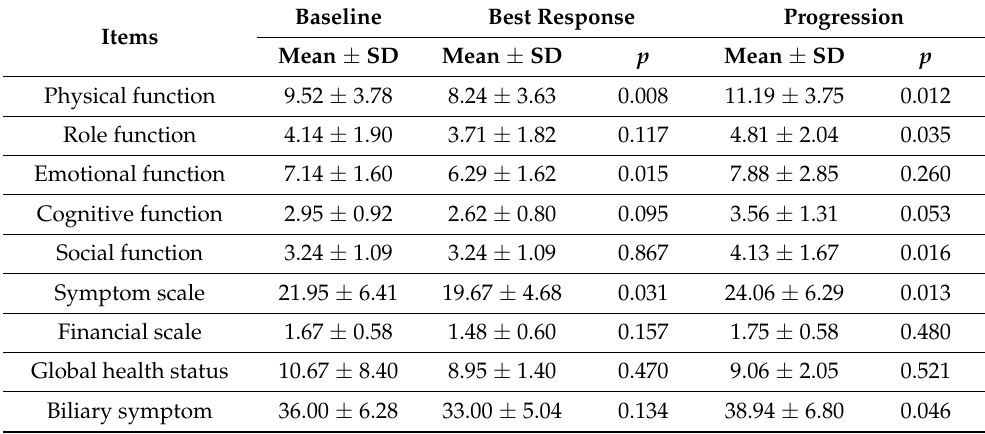
Table 3. Changes in the quality of life of the patients, presented as absolute values.